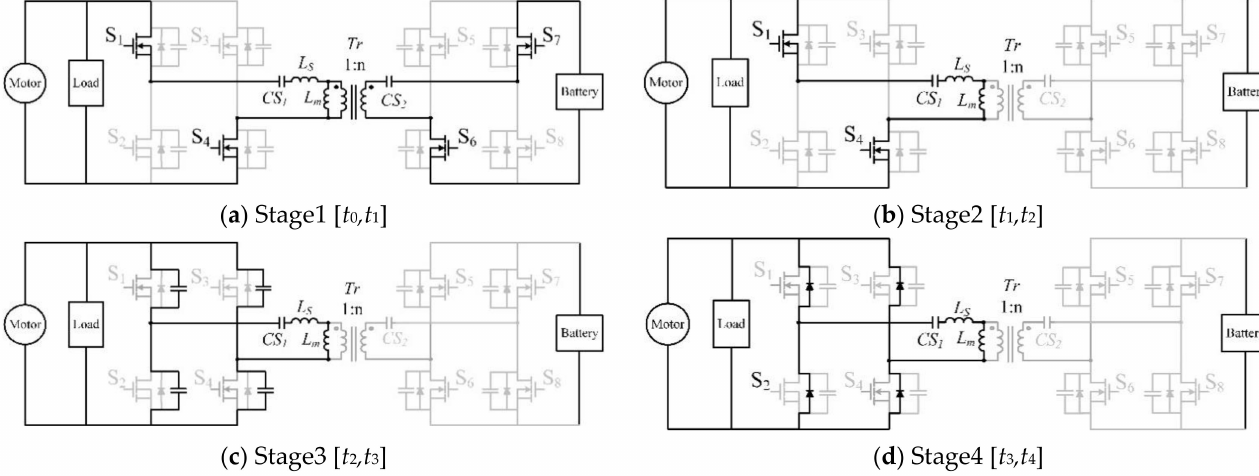
Figure 6. The operating states of the bidirectional full-bridge LLC resonant converter using an MT-4 resonant tank. ( a ) Stage1 [ t 0 ,t 1 ]; ( b ) Stage2 [ t 1 ,t 2 ]; ( c ) Stage3 [ t 2 ,t 3 ]; ( d ) Stage4 [ t 3 ,t 4